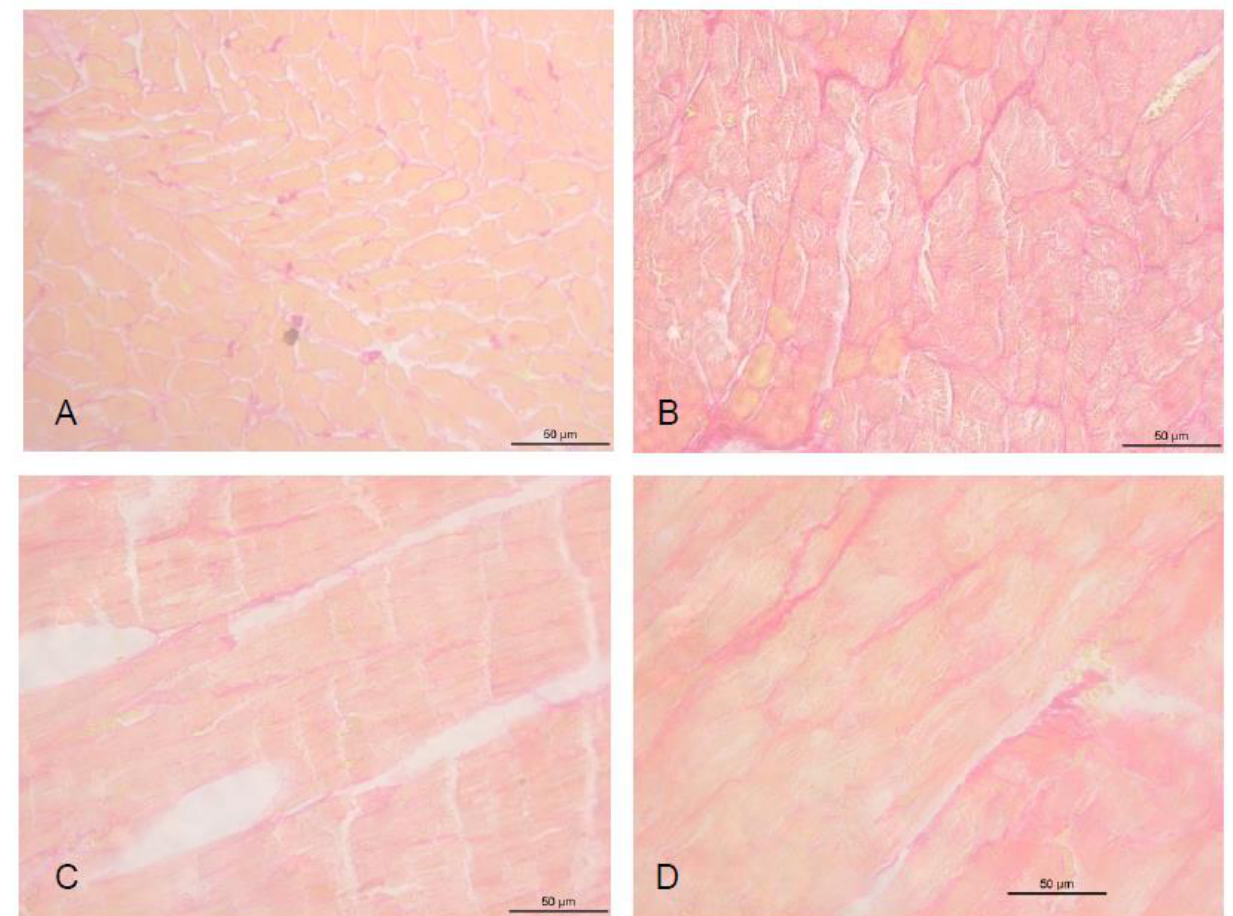
Figure 2. Interstitial Collagen Volume Fraction. ( A ) control animals; ( B ) infarcted animals; ( C ) in- farcted animals supplemented with jaboticaba 2%; ( D ) infarcted animals supplemented with jaboti- caba 4%.